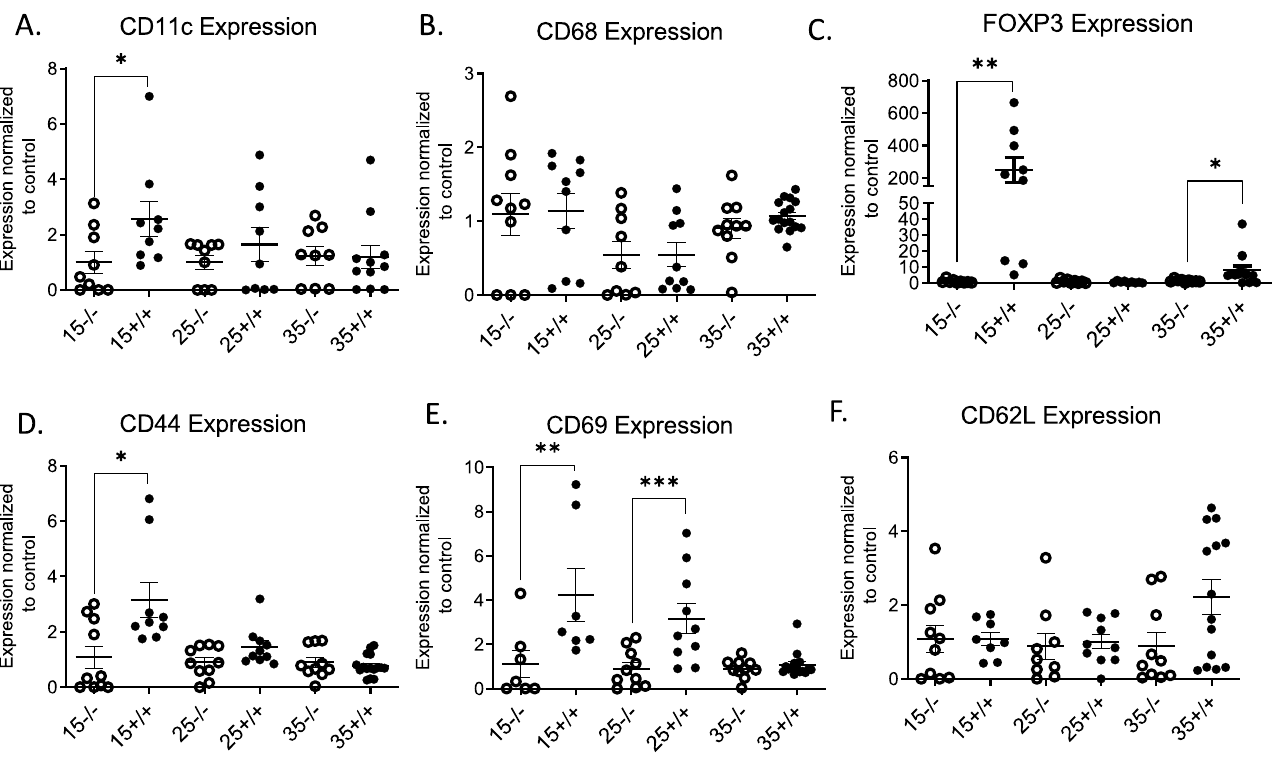
Figure 3. qRT-PCR analysis of BL/6 and BL/6-CD3FLAGmIR mice islet mRNA expression of CD11c, CD68, FOXP3, CD44, CD69, and CD62L. CD11c ( A ), CD68 ( B ), FOXP3 ( C ), CD44 ( D ), CD69 ( E ), and CD62L ( F ) islet mRNA expression at 15 ( n = 3 mice with 3 replicates), 25 ( n = 3 mice with 3 replicates) and 35 weeks ( n = 4 mice with 3 replicates) of age. -/- indicates BL/6 mice and +/+ indicates BL/6-CD3FLAGmIR mice. Both BL/6 and BL/6-CD3FLAGmIR results are compared to the control, beta-globin, a housekeeping gene. Unpaired student t test: * p ≤ 0.05, ** p ≤ 0.01, *** p ≤